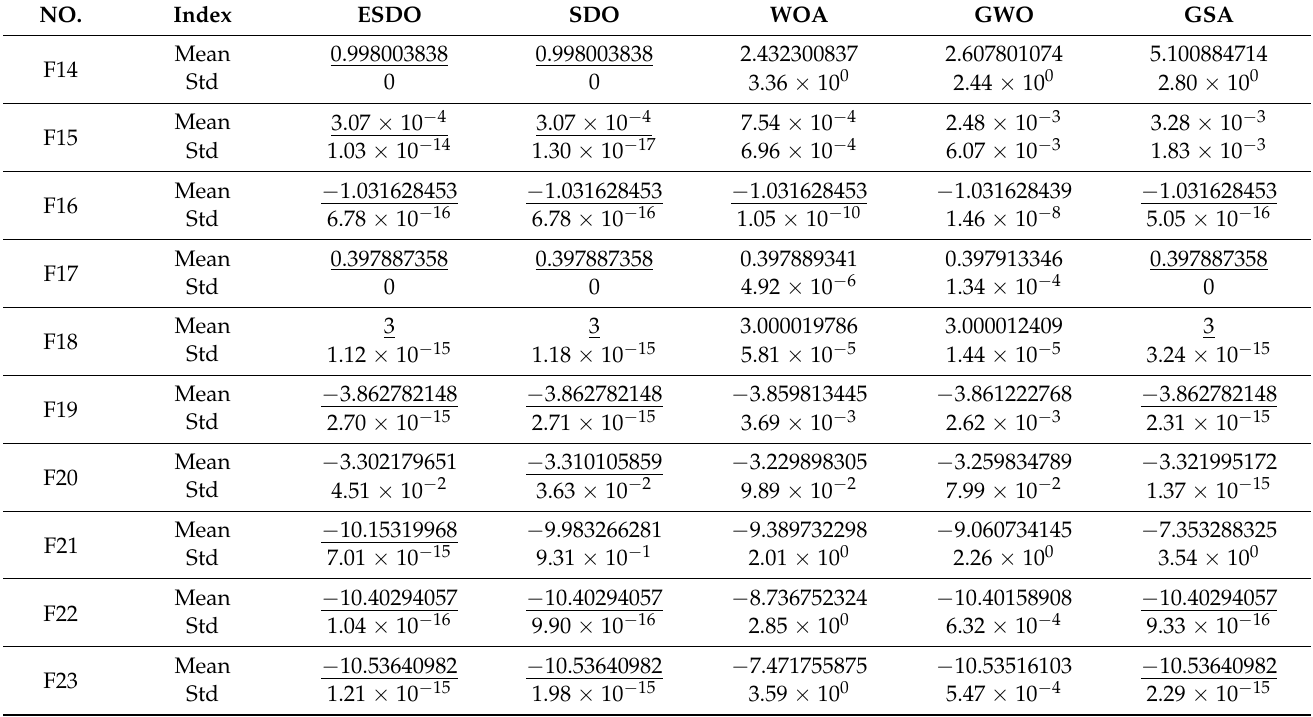
Table 4. Comparison results of LMNs